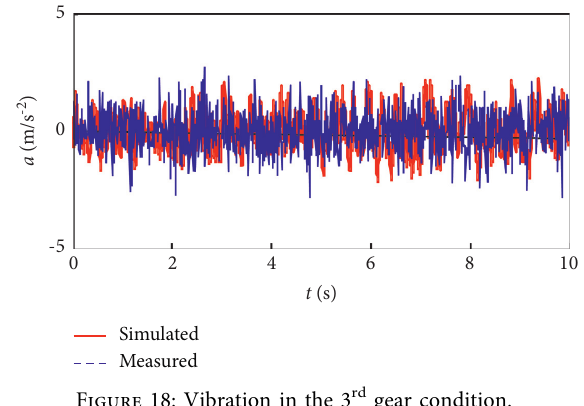
Figure 18: Vibration in the 3 rd gear condition.